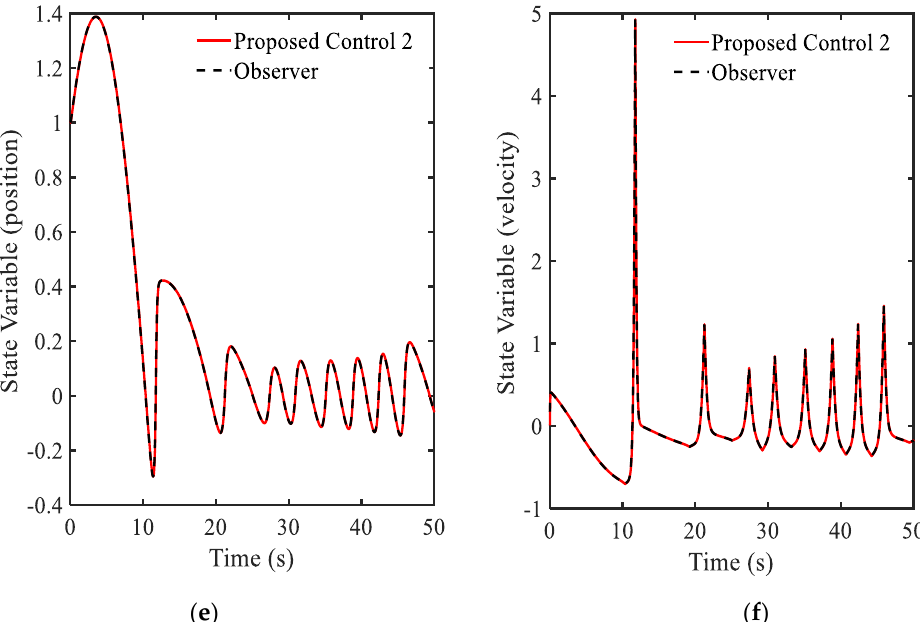
Figure 4. Simulation results of the proposed control 2 with Equation (7): ( a ) gain function Q ∆ L ( t ) , ( b ) main control u ∗ ( t ) , ( c ) state variable x e ( t ) , ( d ) state variable ( f ) large view of state variable